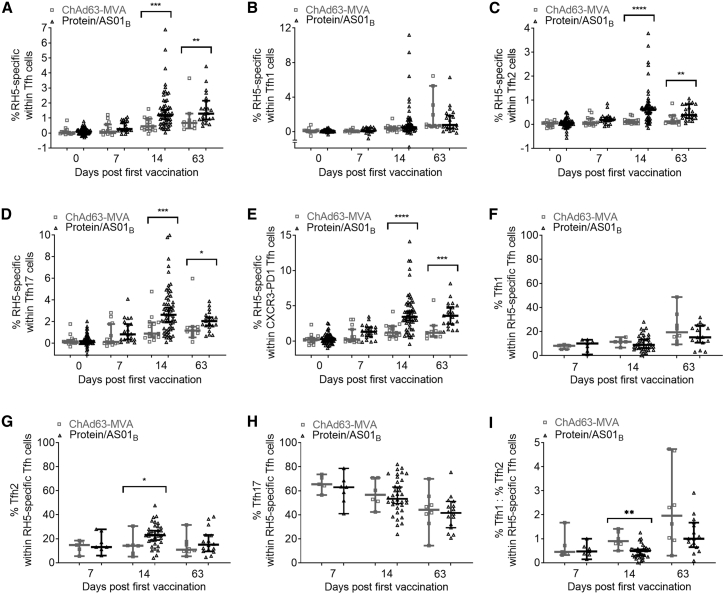
Protein/AS01B platform induces a robust PfRH5-specific response within the cTfh cell population, with a qualitative skew toward Tfh2PBMCs were stimulated as in Figure 2 with PfRH5-specific and Tfh1/2/17 gating as per Figures S4 and S6, respectively. cTfh cells were defined as CXCR5+ cells within CD45RO+CD4+ T cells and delineating the CXCR3-PD1+ subset of CXCR5+CD45RO+CD4+ cTfh.(A–E) Frequencies of PfRH5-specific cells were compared at each time point within cTfh cells (A), Tfh1 cells (B), Tfh2 cells (C), Tfh17 cells (D), and CXCR3−PD1+ cells (E).(F–I) Within the PfRH5-specific cTfh cell population, the proportion of cells at each time point that was Tfh1 cells (F), Tfh2 cells (G), Tfh17 cells (H), or the ratio of %Tfh1:Tfh2 (I) was also compared between platforms. All of the available samples were analyzed (ChAd63-MVA/protein/AS01B): day 0, n = 15/57; day 7, n = 15/20; day 14, n = 15/57; and day 63, n = 11/22.In (B–E), samples were excluded if the total number of Tfh1/Th2/Th17 or CXCR3−PD1+ cells was <50 in either the medium alone or PfRH5 peptide pool sample (ChAd63-MVA/protein/AS01B): day 0, n = 15/55–57; day 7, n = 15/19–20; day 14, n = 15/ 55–57; and day 63, n = 11/21. In (F–I), data points were excluded if the total number of responding cTfh cells was <50 (ChAd63-MVA/protein/AS01B): day 7, n = 5/7; day 14, n = 6/36; and day 63, n = 8/16. Comparisons between trials were performed using Mann-Whitney tests. ∗p < 0.05, ∗∗p < 0.01, ∗∗∗p < 0.001, and ∗∗∗∗p < 0.0001. In all of the panels, each point represents a vaccinee. Lines denote medians and interquartile ranges.